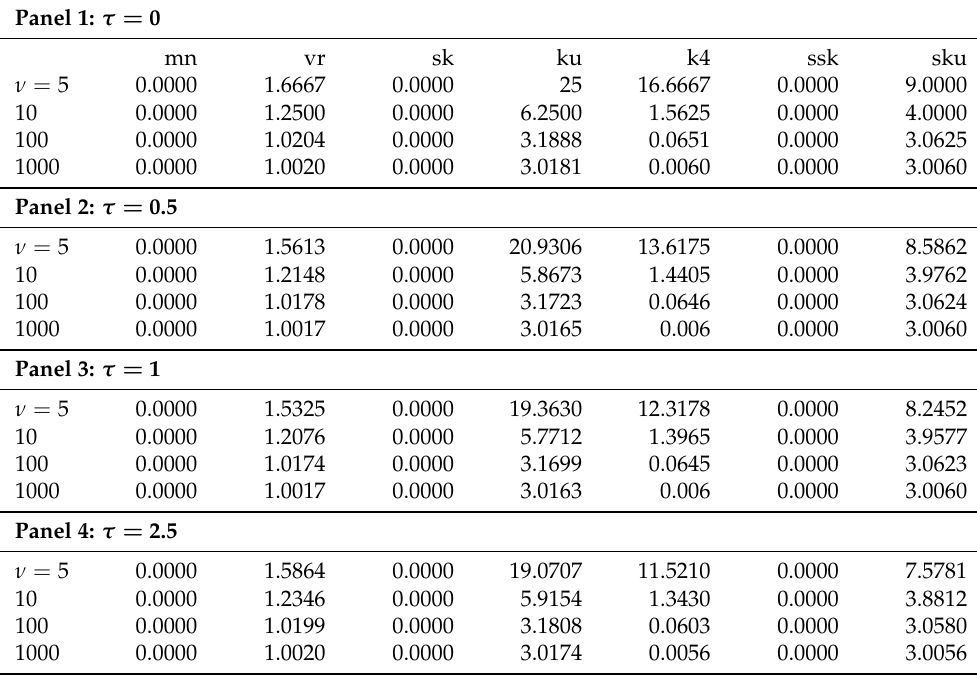
Table 7. Extended skew-Student moments, λ = 0 , τ ≥ 0